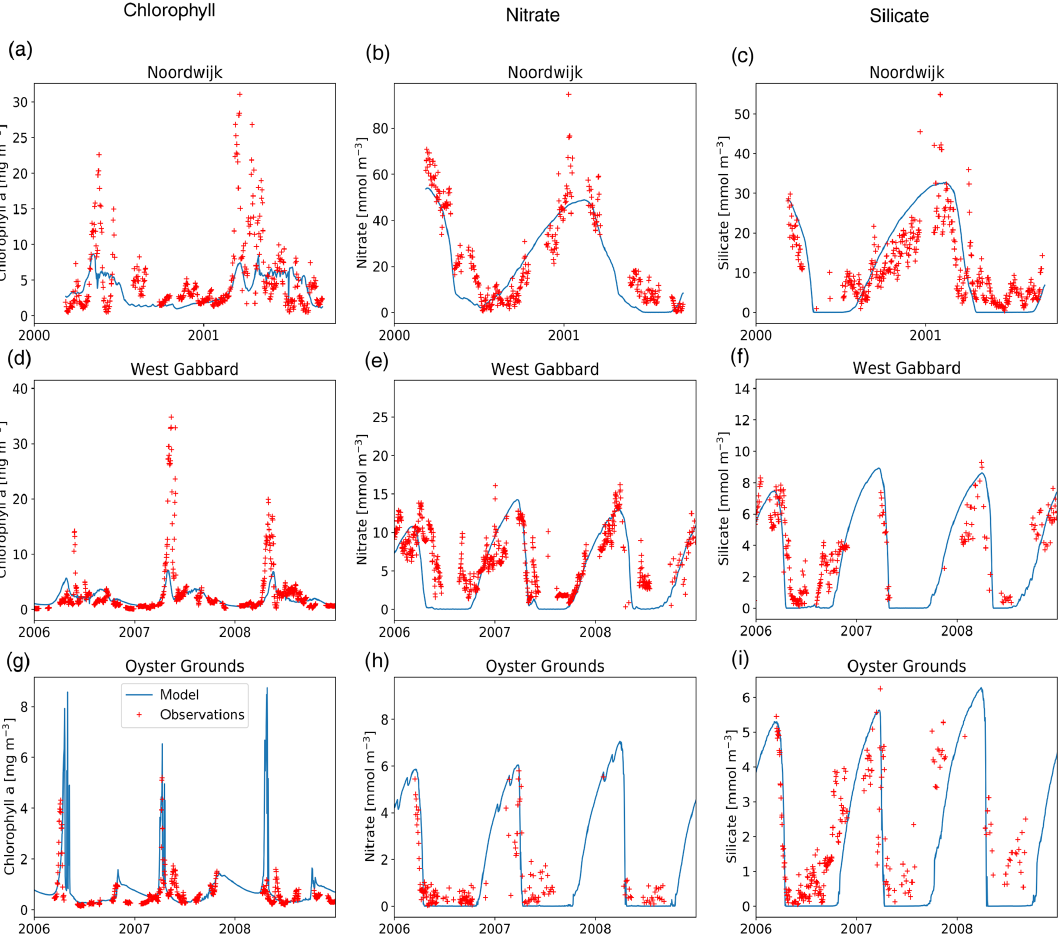
Figure 2. Assessment of the model’s performance (blue line) for the three locations through comparison with observations from the Smart- Buoys (red crosses). The variables of chlorophyll a (a, d, g) , nitrate (b, e, h) and silicate (c, f, i) are